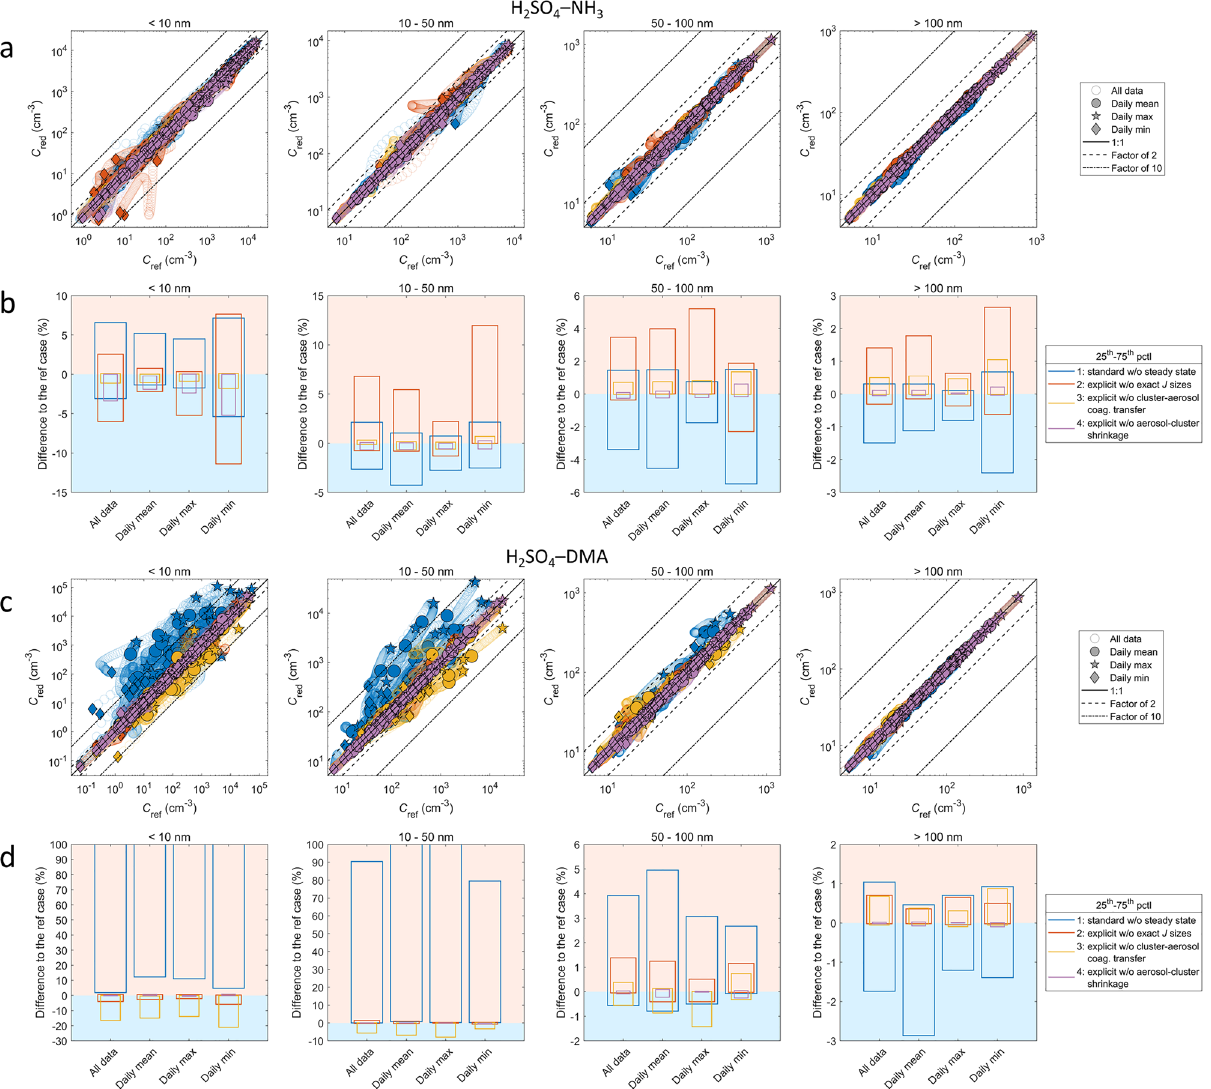
Figure 5. Particle number concentrations C red and C ref and their differences Δ C test = ( C red − C ref ) / C ref for test simulations assessing the roles of different gas–cluster–aerosol dynamics processes for all trajectories with initial particle formation from H 2 SO 4 –NH 3 ( a,b ), and H 2 SO 4 –DMA ( c , d ). Each test case “red” is compared to a reference case “ref”, where “red” refers to the reduced or simplified case, and “ref” to the benchmark case; that is, Δ C test always corresponds to the error made due to the omission of one of the cluster dynamics processes (Supplementary Table S3). Each test is depicted by one color as shown in the legend. For figure clarity, only the 25th–75th percentiles of Δ C test are shown in ( b,d) . Scales of y-axes are limited to better show lower values in ( d) , for which the 75th percentiles extend to up to several hundred percent for < 10 nm and up to ca. 150% for 10–50